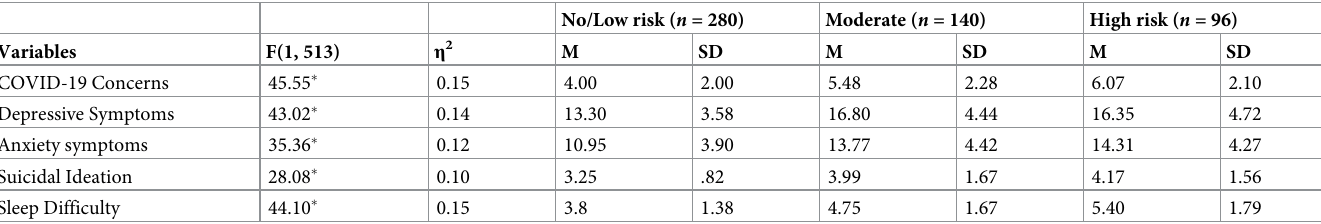
Table 3. ANOVA (F) ratios, means and standard deviations of the no/low, moderate and high risk groups on the study variables. No/Low risk ( n = 280) Moderate ( n = 140) High risk ( n = 96) Variables F(1, 513)